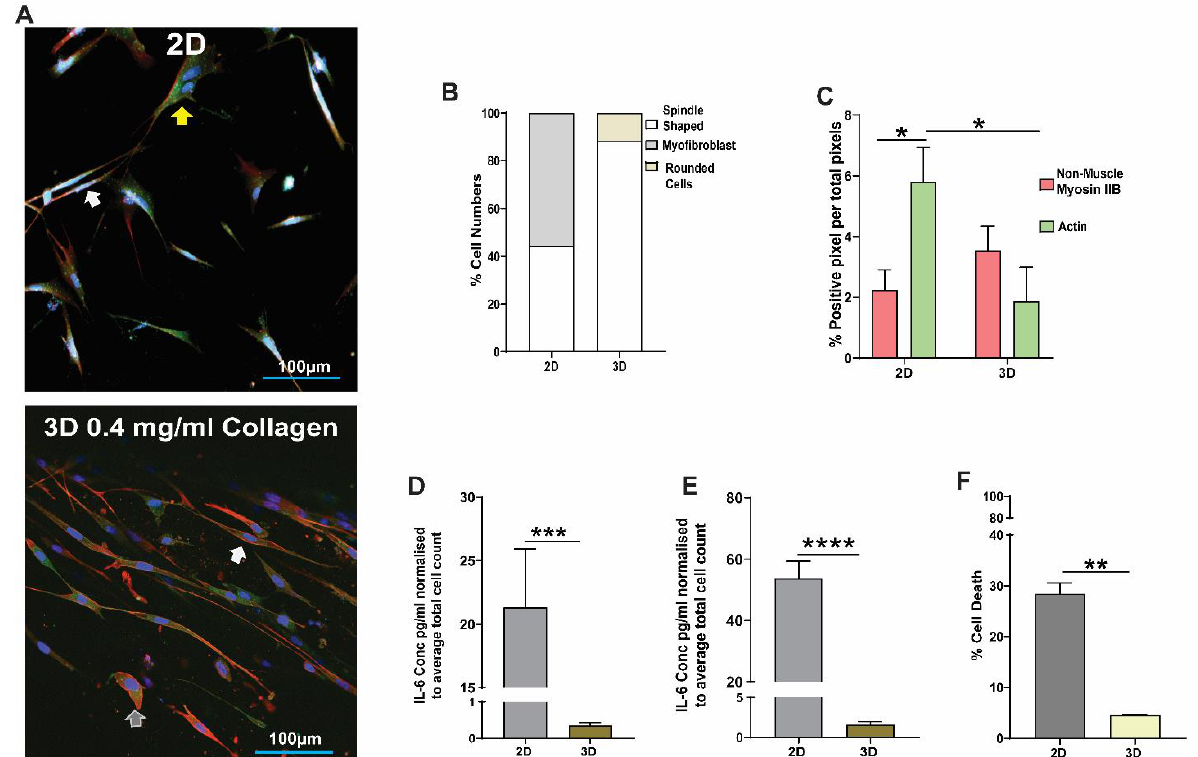
Figure 2. The effect of 2D and 3D collagen-I models on lung fibroblast phenotype and function. Human fetal lung 1 (HFL1) fibroblasts were cultured in a 2D monolayer on collagen-coated flexible Bioflex plates or embedded in 3D collagen-1 gels and cultured for 24 h. Representative confocal image of HFL1s in ( A ) 2D monolayer and ( B ) 3D collagen-1 gels after culturing for 24 h and staining for non-muscle myosin IIB (red) and F-actin (green). ( C ) Percentage cell numbers of spindle shaped, myofibroblast, and rounded HFL1 fibroblasts in 2D and 3D culture models. ( D ) Percentage positive pixel count per total number of pixels in images of 2D and 3D culture models. The concentration of ( E ) IL-6 and ( F ) IL-8 cytokines released from HFL1 fibroblasts in 2D and 3D culture models nor- malized to total cell counts. The percentage cell viability of HFL1 fibroblasts in 2D and 3D culture models. Mean ± SEM indicated for 3 technical replicates, n = 6. * p < 0.05, ** p < 0.01, *** p < 0.001, **** p <